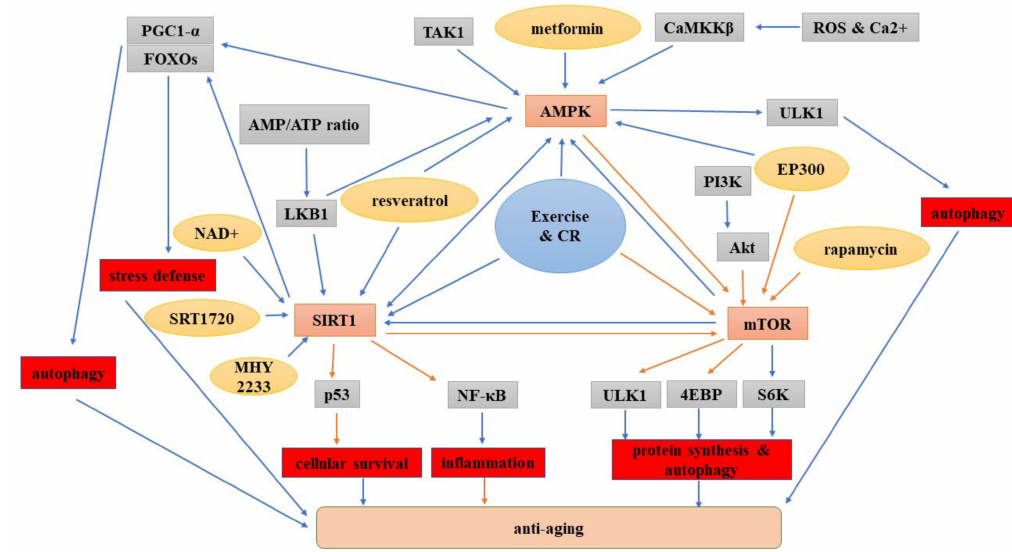
Figure 4. Illustration of the roles of the AMPK, SIRT1 and mTOR signaling pathways in aging. The blue arrows indicate a positive effect, and the orange arrows indicate a negative effect. Abbreviations: CR: caloric restriction; NF- κ B: NF-kappa